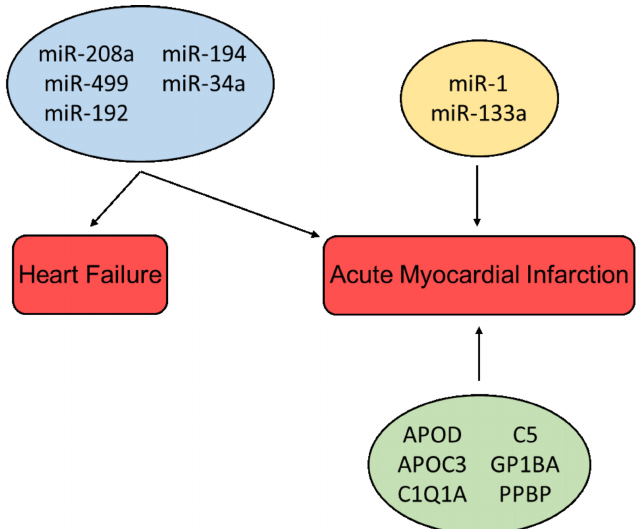
Figure 4. Cardioprotective factors associated with the diagnosis and prognosis of heart failure and acute myocardial infarction. miRs in the blue box are associated with multiple pathologies; miRs in the yellow box and proteins in the green box are associated with a single